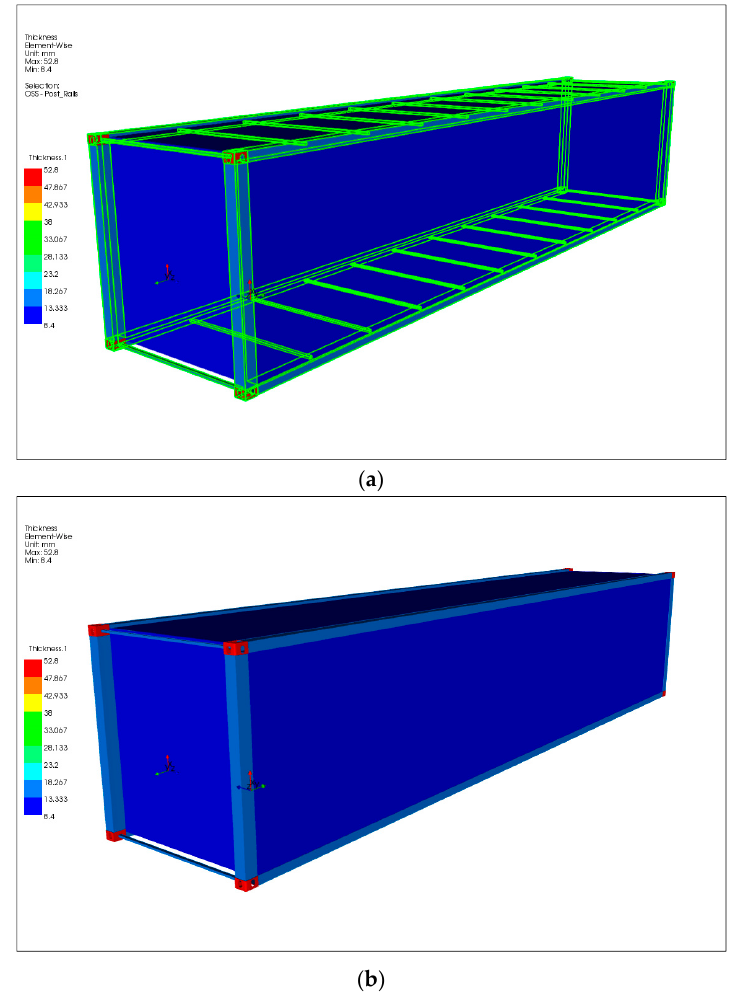
Figure 4. ( a ) Corner posts, corner fittings, bars, and rails are highlighted. ( b ) 40-foot composite container. Thicknesses of composite layers are